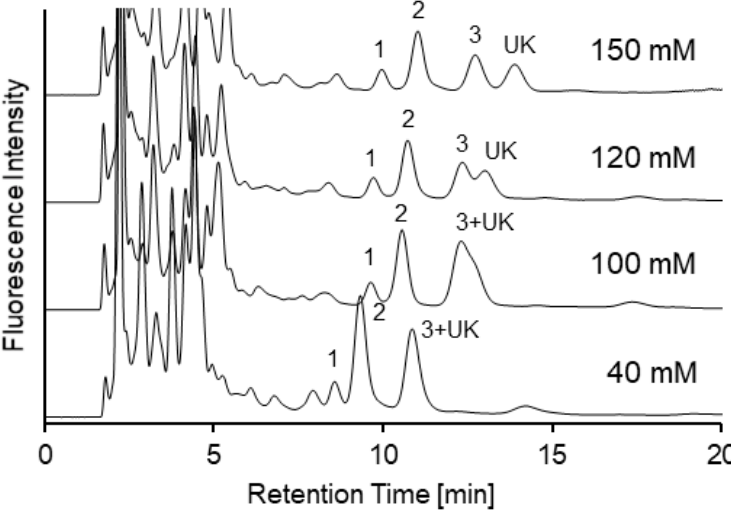
Figure 3. Chromatograms of mouse urine samples with different buffer concentration. Mobile